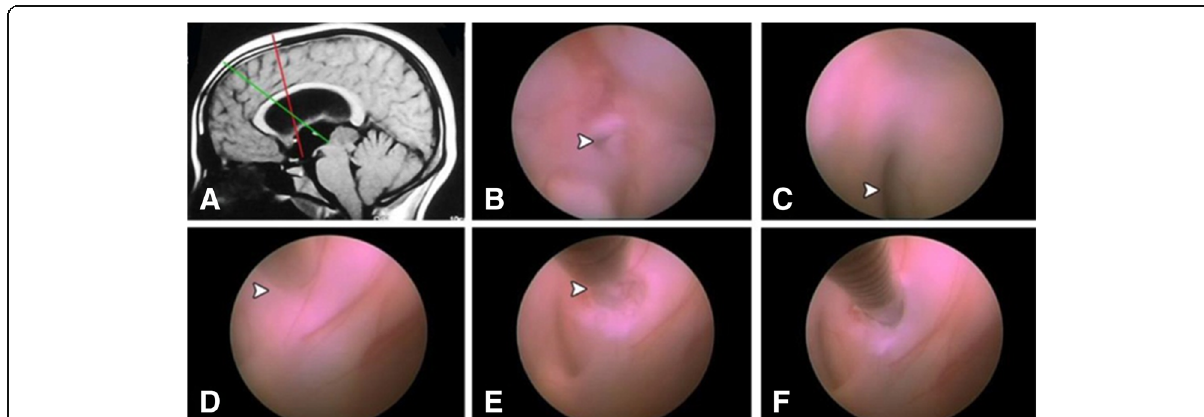
and the green line represents the pathway for tumor biopsy. The lines are more than 3 cm away from each other necessitating two separate burr-holes. b Endoscopic third ventriculostomy done first (arrow head). c A close up view through the posterior third ventricle showing pineal region tumor obstructing the aqueduct (arrow head). d Initial coagulation on ependymal lining. e Biopsy forceps (arrow head) is directed through